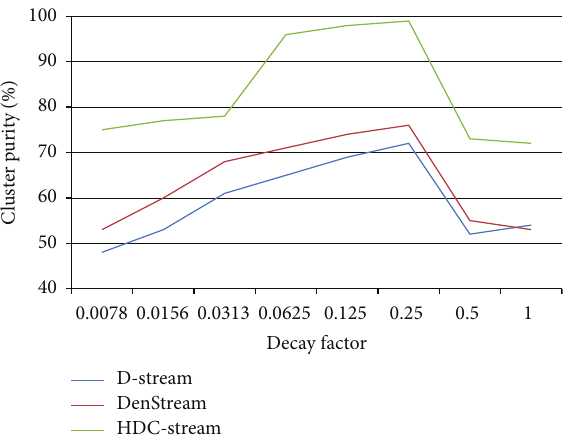
Figure 10: Cluster quality versus decay